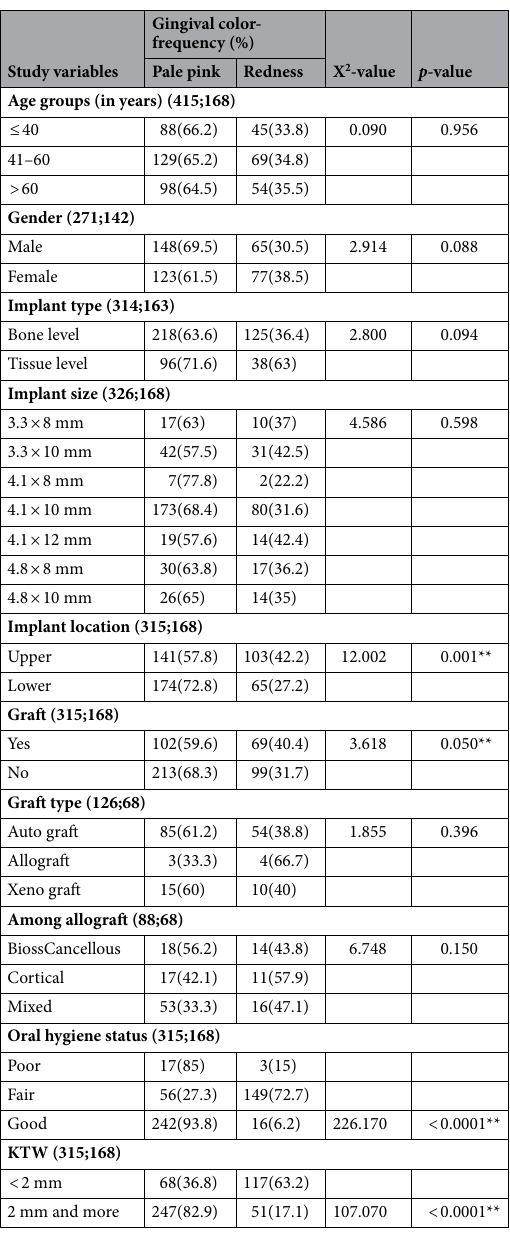
Table 4. Association between Gingival color and other study variables. *Keratinized tissue width. **Statistically